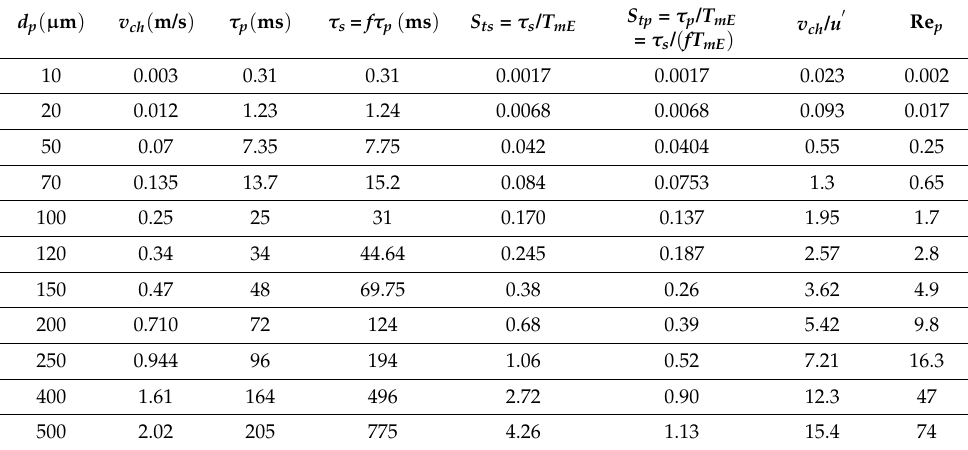
Table 2. Particle properties and dimensionless control